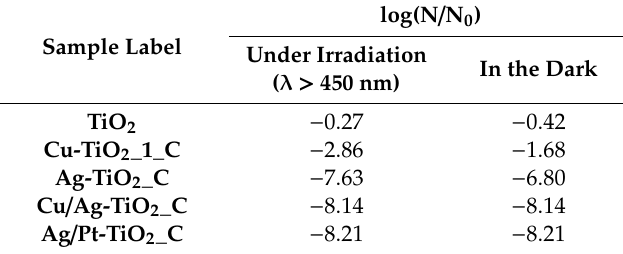
Figure 9. Antimicrobial activity ( a ) in the dark and ( b ) under visible light ( λ > 450 nm). Table 3. Biocidal activity against E. coli